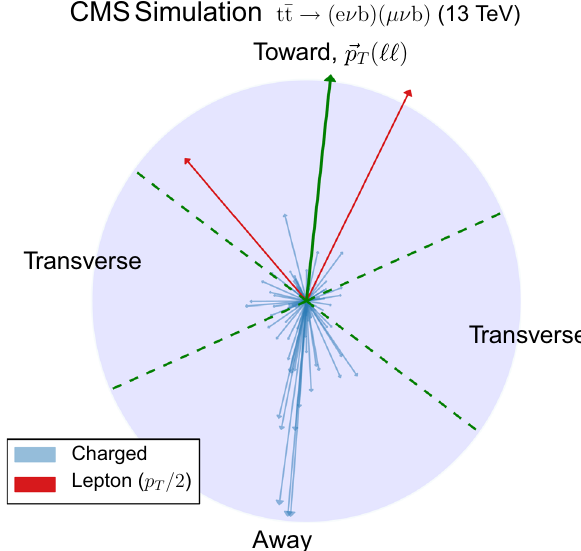
Fig. 3 Display of the transverse momentum of the selected charged particles, the two leptons, and the dilepton pair in the transverse plane corresponding to the same event as in Fig. 1. The p T of the particles is proportional to the length of the arrows and the dashed lines represent the regions that are defined relative to the (cid:7) p T ((cid:6)(cid:6)) direction. For clarity, the p T of the leptons has been rescaled by a factor of 0.5